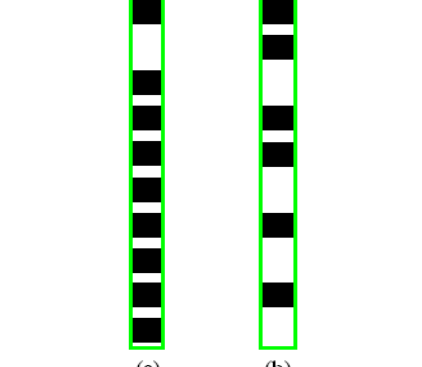
Figure 8. Example of a dense piece and sparse piece: ( a ) dense piece; ( b ) sparse piece. The black area represents characters, and the white area represents blank spaces.